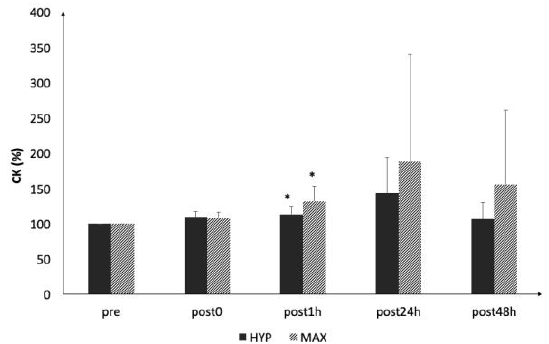
Figure 4. Acute changes in serum creatine kinase (CK) concentrations. * statistically significant di ff erence to baseline ( p < 0.05).